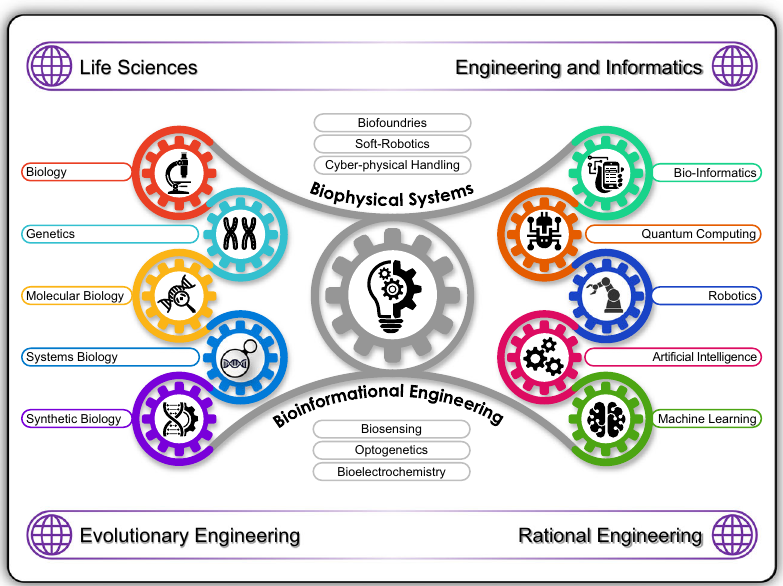
Fig. 1 Synthetic biology ’ s biophysical and bioinformational contexts. Synthetic biology has become a complex network of interrelated disciplines, practices, and policy spaces. The discipline ’ s policy-practitioner engagement needs to be widened to include each of these spaces, and, deepened so that each space understands its impact on the